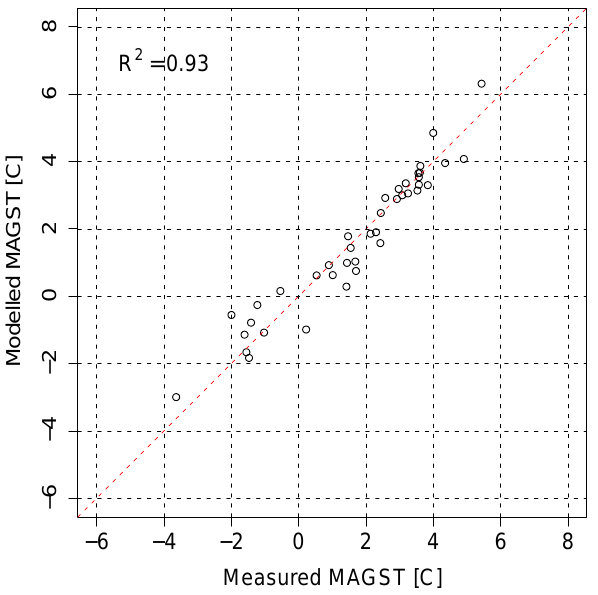
Fig. 6. MAGST of all footprints plotted against elevation. Colors